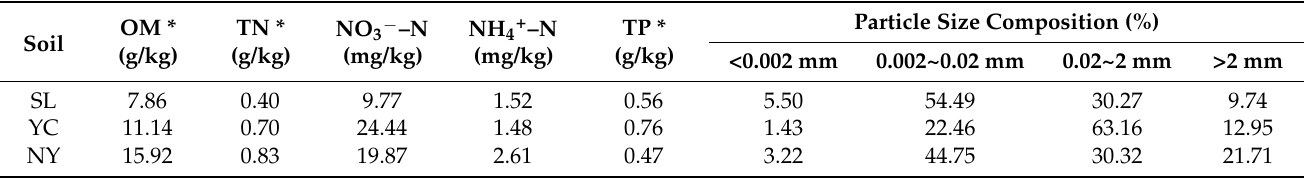
Table 1. The physical and chemical properties of the three